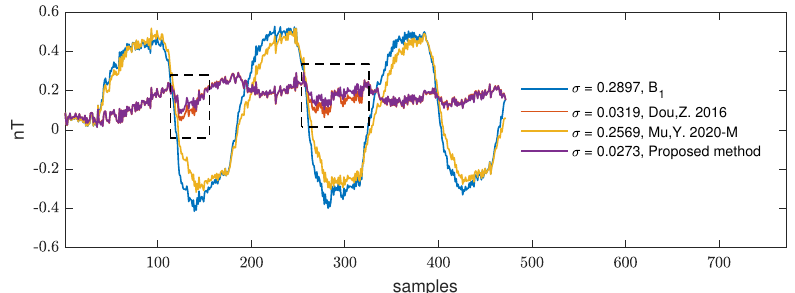
Figure 9. Performance of three methods in the maneuvering process.